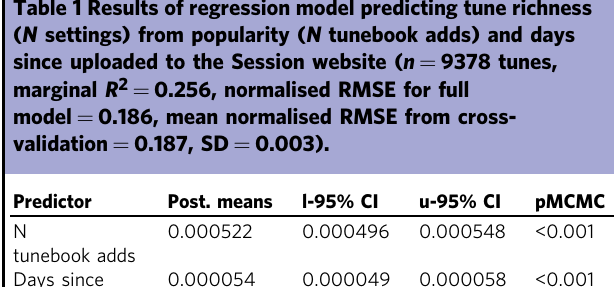
Table 1 Results of regression model predicting tune richness